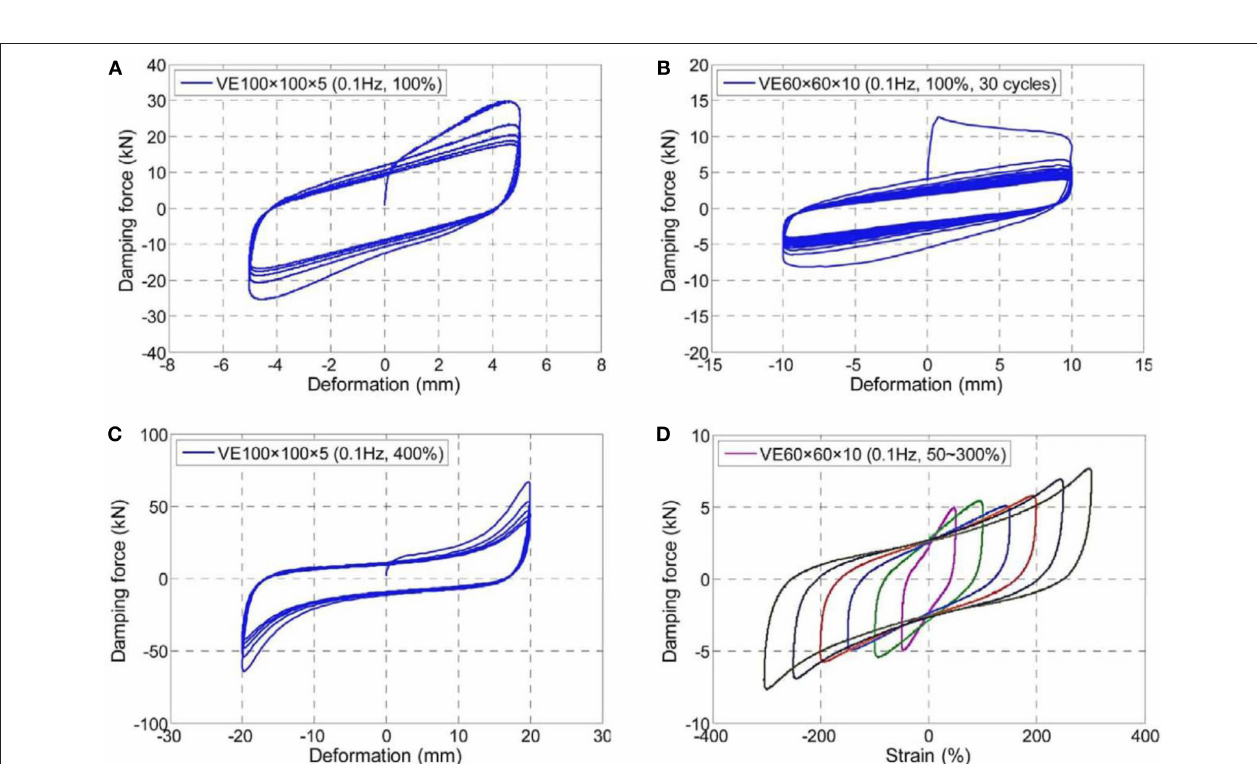
FIGURE 3 | Performance test results of (A) typical hysteresis curve, (B) fatigue test, (C) ultimate strain test, and (D) different strain amplitude tests.